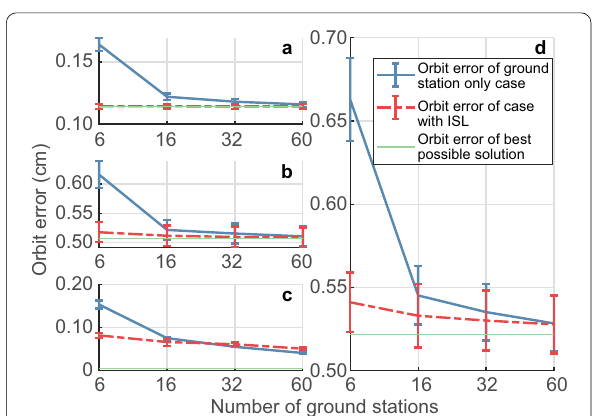
Number of ground stations Fig. 6 Mean RMS of orbit errors with respect to the number of ground stations in a radial, b along-track, and c cross-track directions and d 3D position for global networks. Note in different